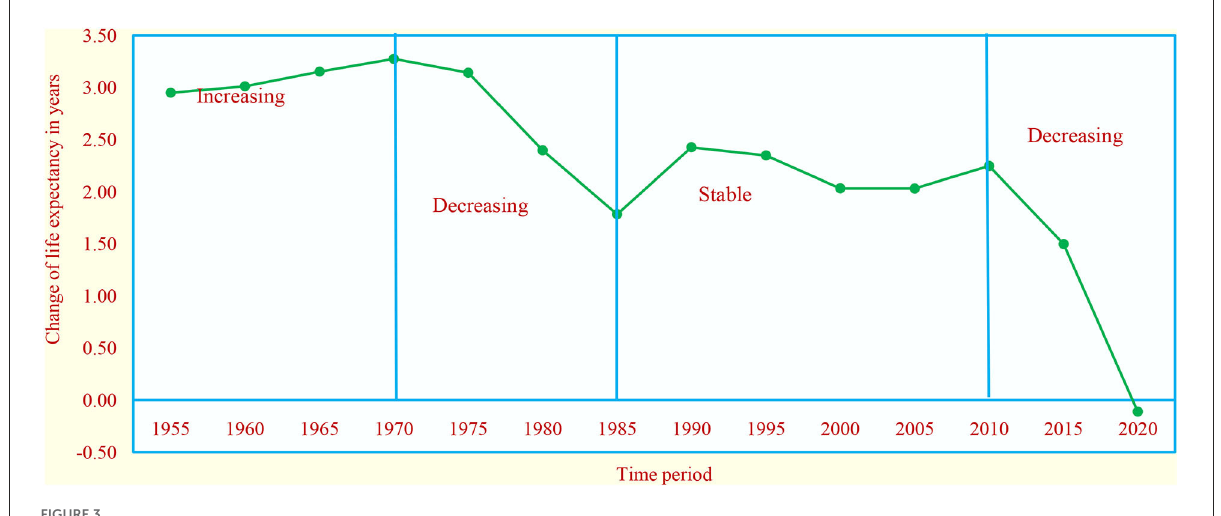
FIGURE3 Years of life expectancy change in five–year intervals in